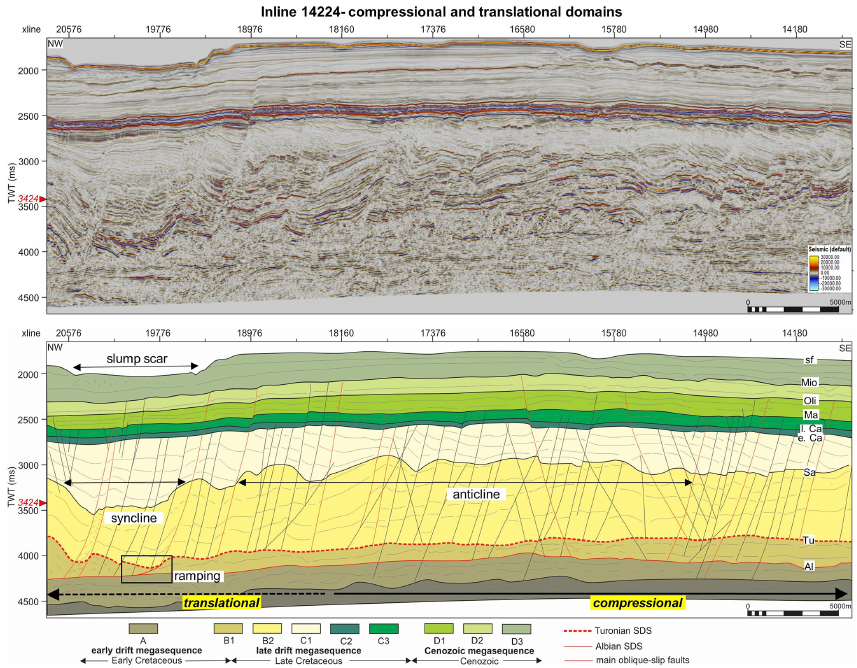
Figure 7. Uninterpreted and interpreted sections of inline 14224 showing the compressional domain and position of time slice 3424. The section lies roughly along-strike the DWFTBs giving a view of the oblique-slip faults that crosscut them. Present-day slumping is evident above a Late Cretaceous syncline. Abbreviations: A – Albian; Tu – Turonian; Sa – Santonian; Ma – Maastrichtian; Oli – Oligocene; Mio – Miocene; sf – seafloor; SDS – shale detachment surface. Vertical exaggeration: